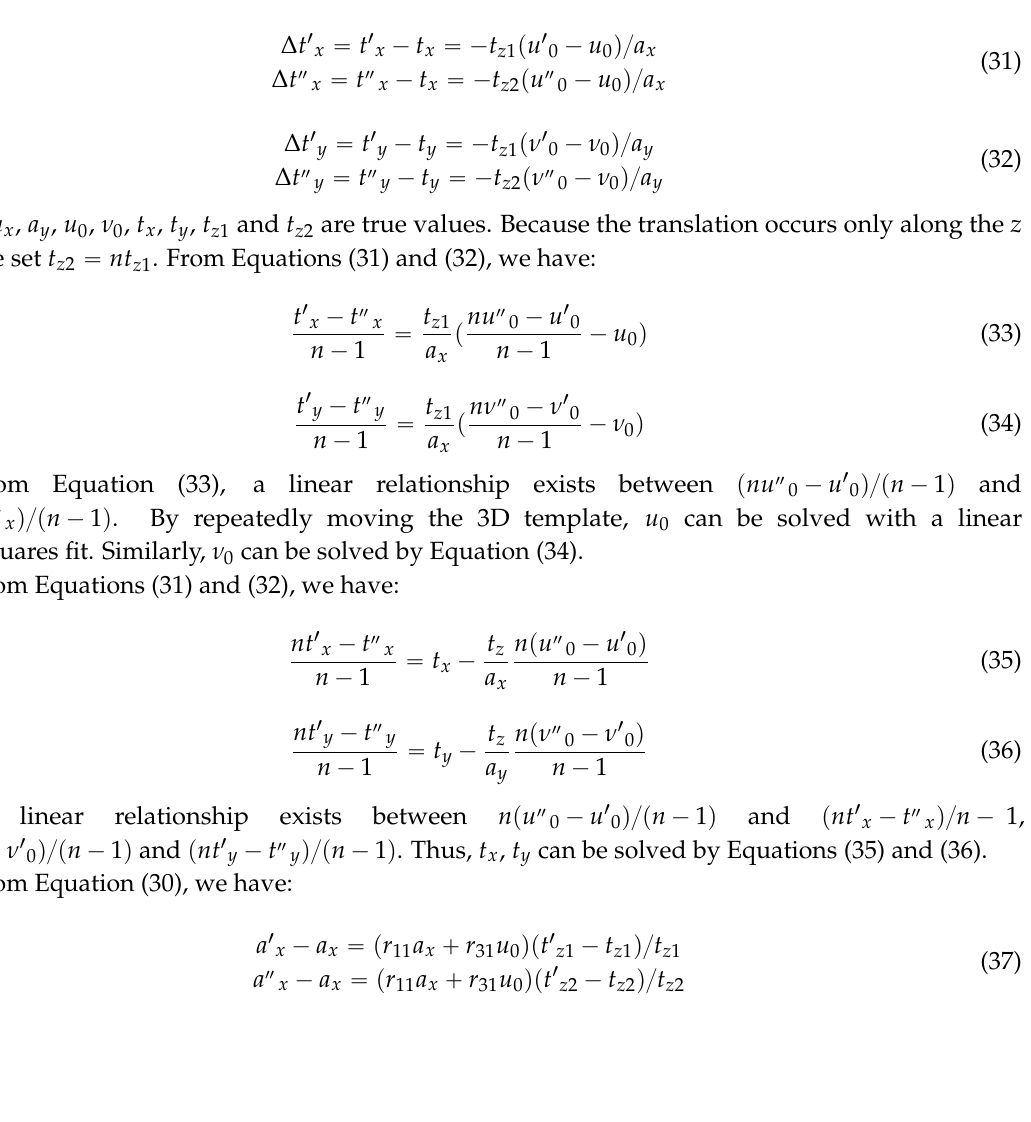
Figure 5. Error approximate analysis: ( a ) a x error comparison; ( b ) a y error